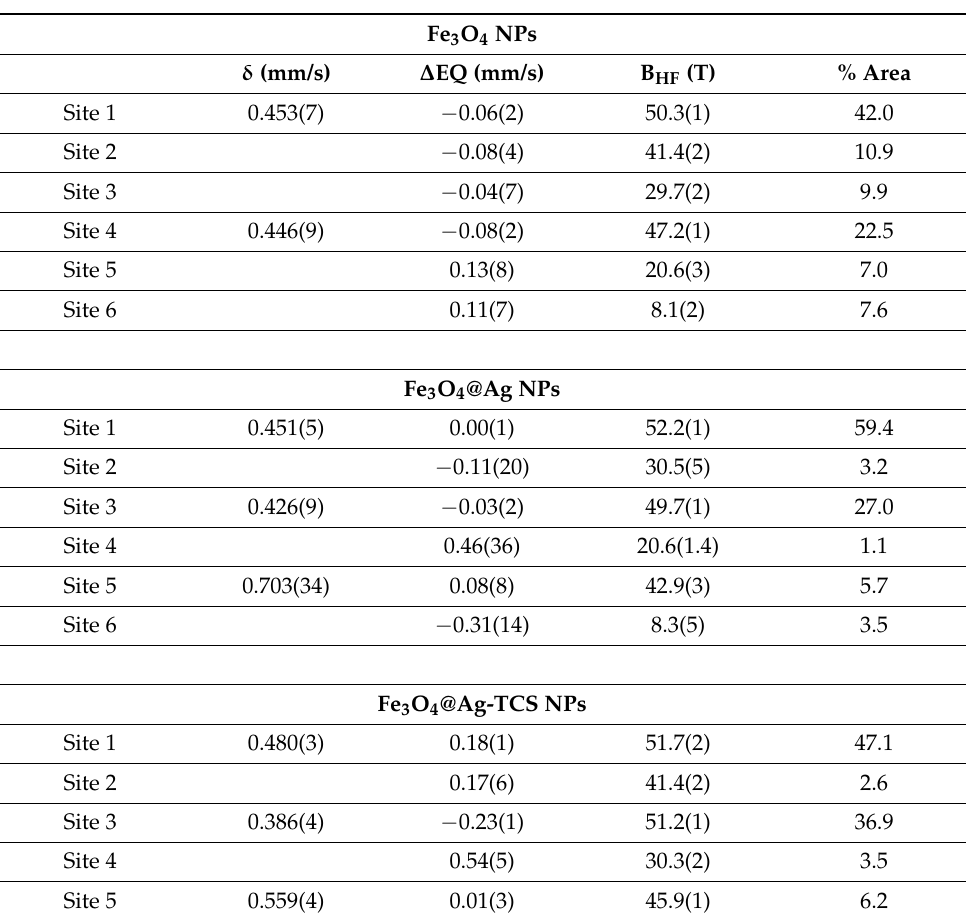
Table 1. Isomer shift, quadrupole splitting, magnetic hyperfine field, and spectral area of the Mössbauer spectrum of Fe 3 O 4 NPs, Fe 3 O 4 @Ag NPs, and Fe 3 O 4 @Ag/TCS NPs, in which ∆ EQ is the quadrupole splitting and B HF is the magnetic hyperfine